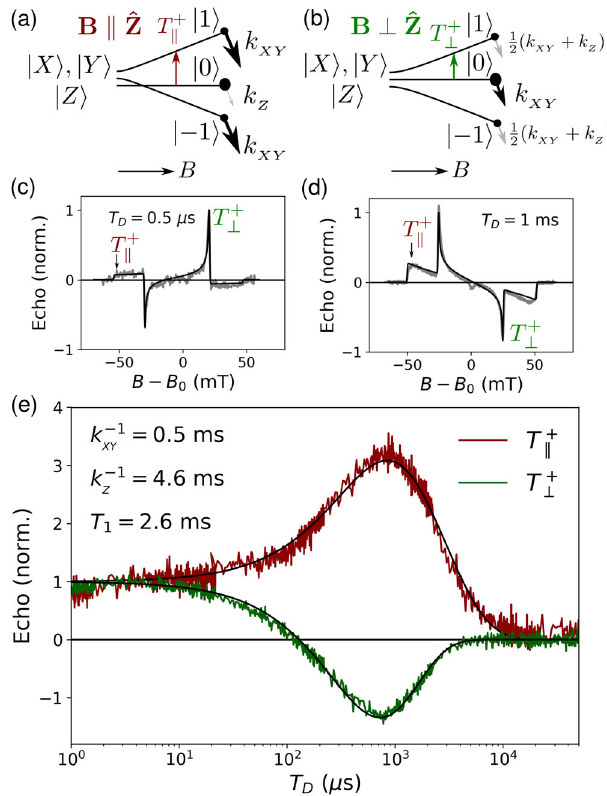
FIG. 4. Spin-orbit mediated decay of uncoupled triplet excitons formed by singlet fission. (a) Spin sublevel decay schematic for B k ˆ Z with a decay rate of k for the j 0 i state and k for the j (cid:2) 1 i Z XY ˆ Z states.(b)Decayschematicfor B ⊥ withadecayrateof k forthe XY ð k þ k Þ for the j (cid:2) 1 i states. (c),(d) Echo- j 0 i state and 1 2 XY Z ¼ 1 μ s and T ¼ 1 ms along detected spectra (gray) with T D D with simulations (black) for overpopulation of the Zeeman j 0 i state, and the zero-field j Z i state, respectively. (e) Experimental lifetime measurements for the T þ and T þ ⊥ field positions shown k ¼ 0 . 51 (cid:2) 0 . 03 ms, k − 1 ¼ in (c) and (d), along with a fit giving k − 1 XY Z ¼ 2 . 6 (cid:2) 0 . 1 4 . 6 (cid:2) 0 . 2 ms, and spin-lattice relaxation time T 1